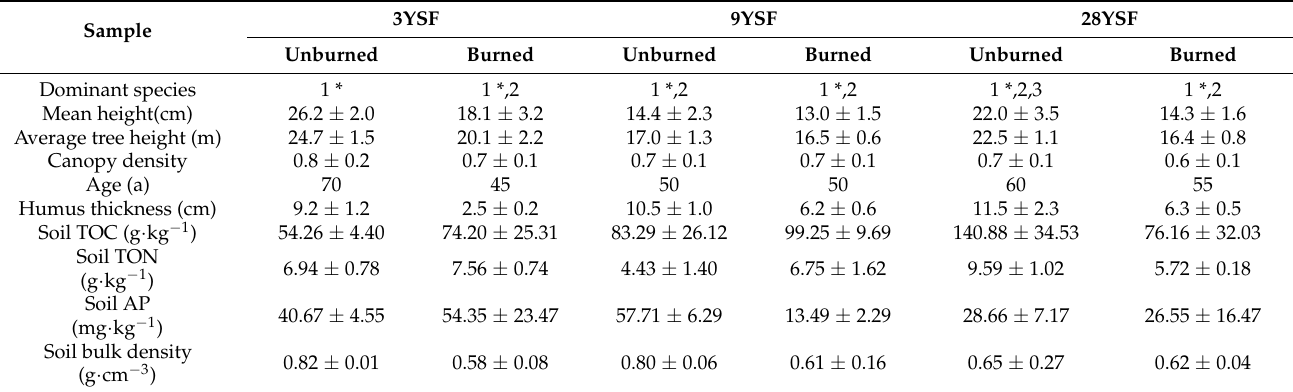
Table 1. Overview of the study area ( n =